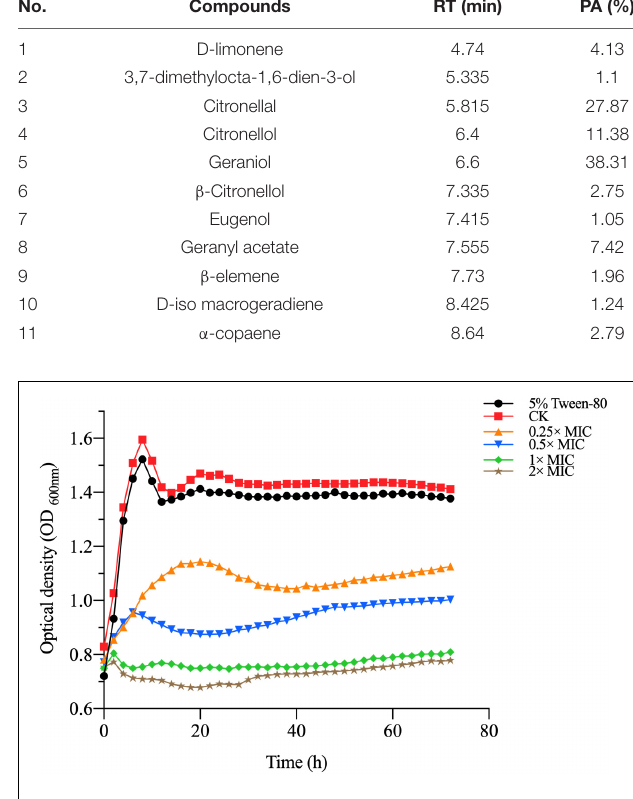
FIGURE 1 | The V. parahaemolyticus growth curves. CK is the V. parahaemolyticus without Melissa officinalis L. essential oil treated.